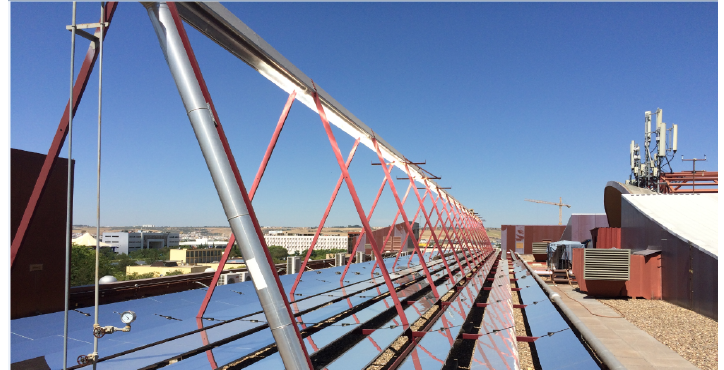
Figure 2. Fresnel collector field.